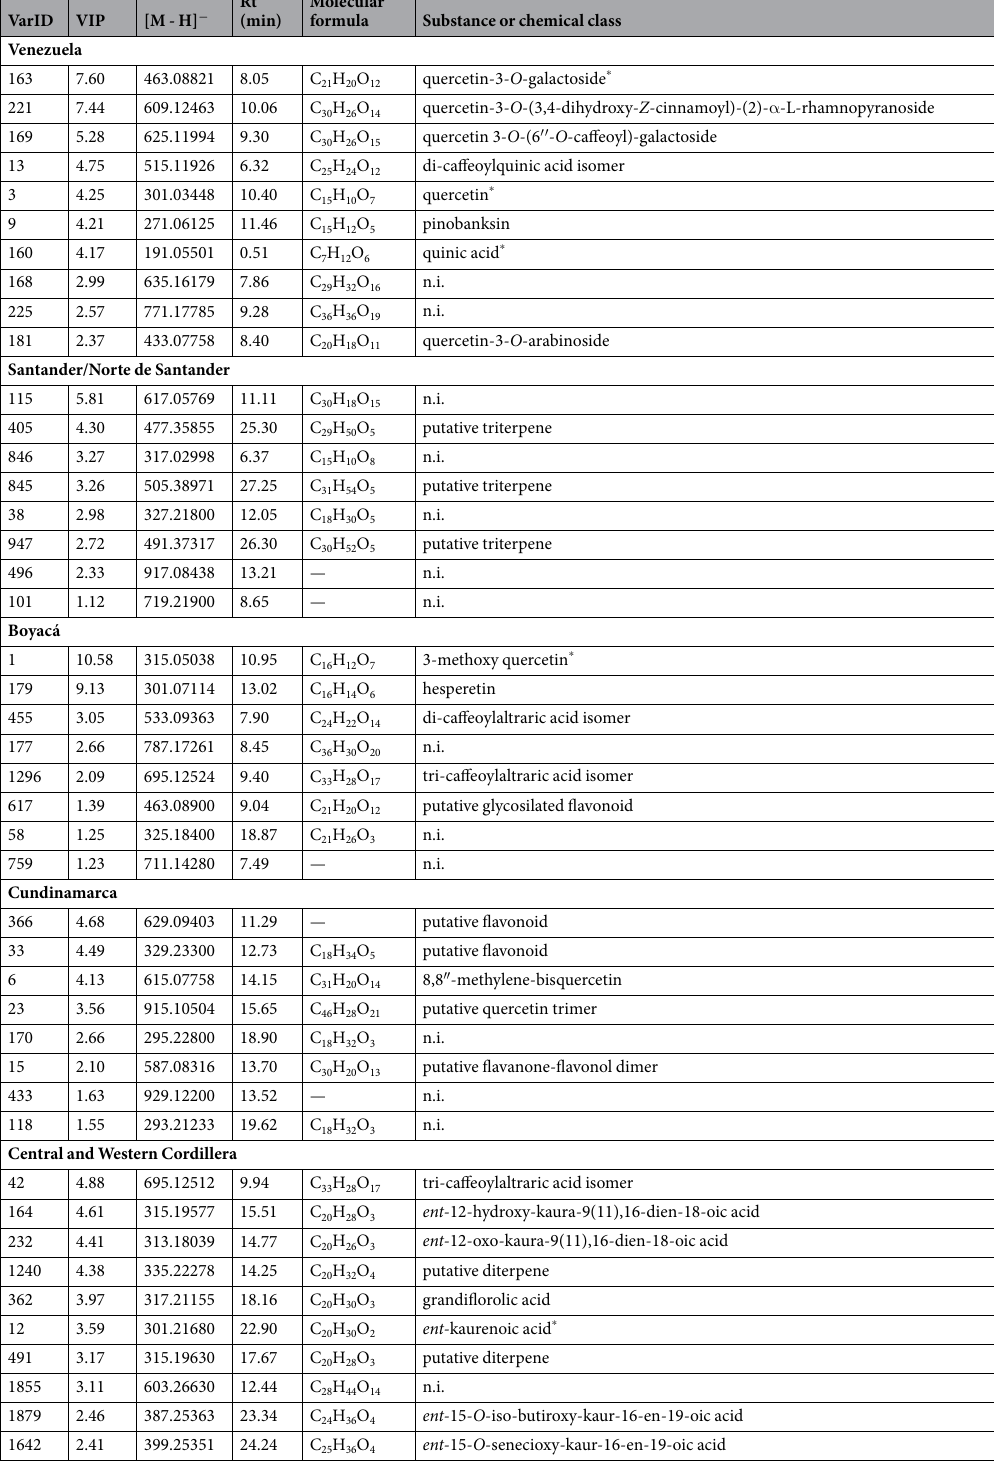
Table 1. Main discriminatory substances of the geographical origin of species from the genus Espeletia analyzed by UHPLC-UV-HRMS. * Reference compound used to confirm identification. n.i.: not